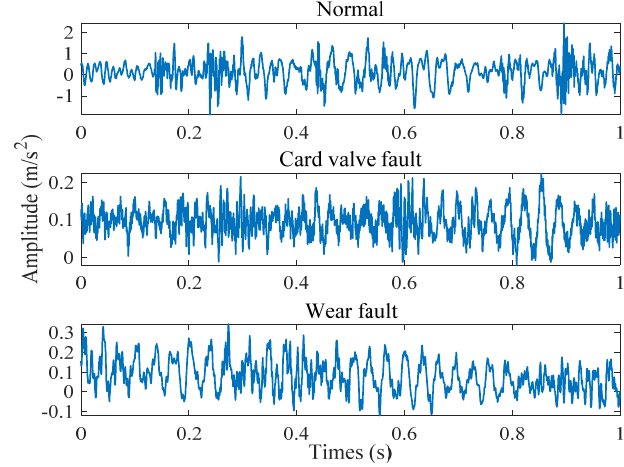
Figure 11. Time − domain diagram of three states of one − way valve.